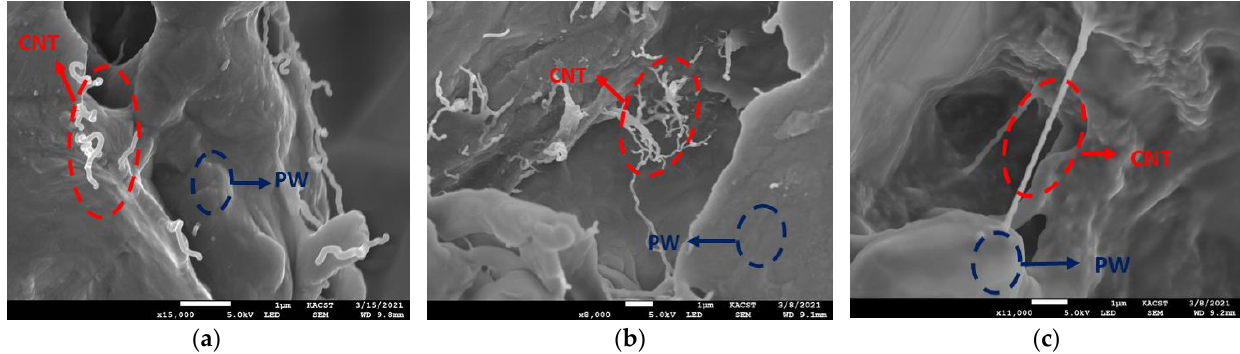
Figure 4. SEM images of the paraffin wax/MWCNT composites: PW-1CNT ( a ), PW-2CNT ( b ), and PW-3CNT ( c ). Scale bars of Figures 4 and 5 are the same (see Figure 5).